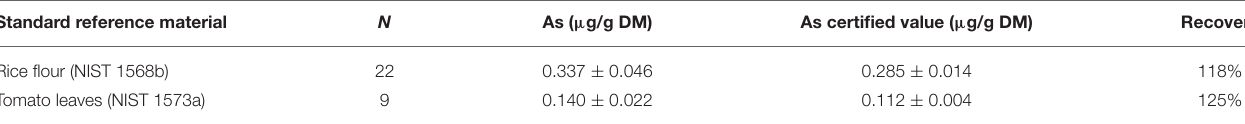
TABLE 1 | Arsenic (As) concentrations in standard reference materials (DM = dry